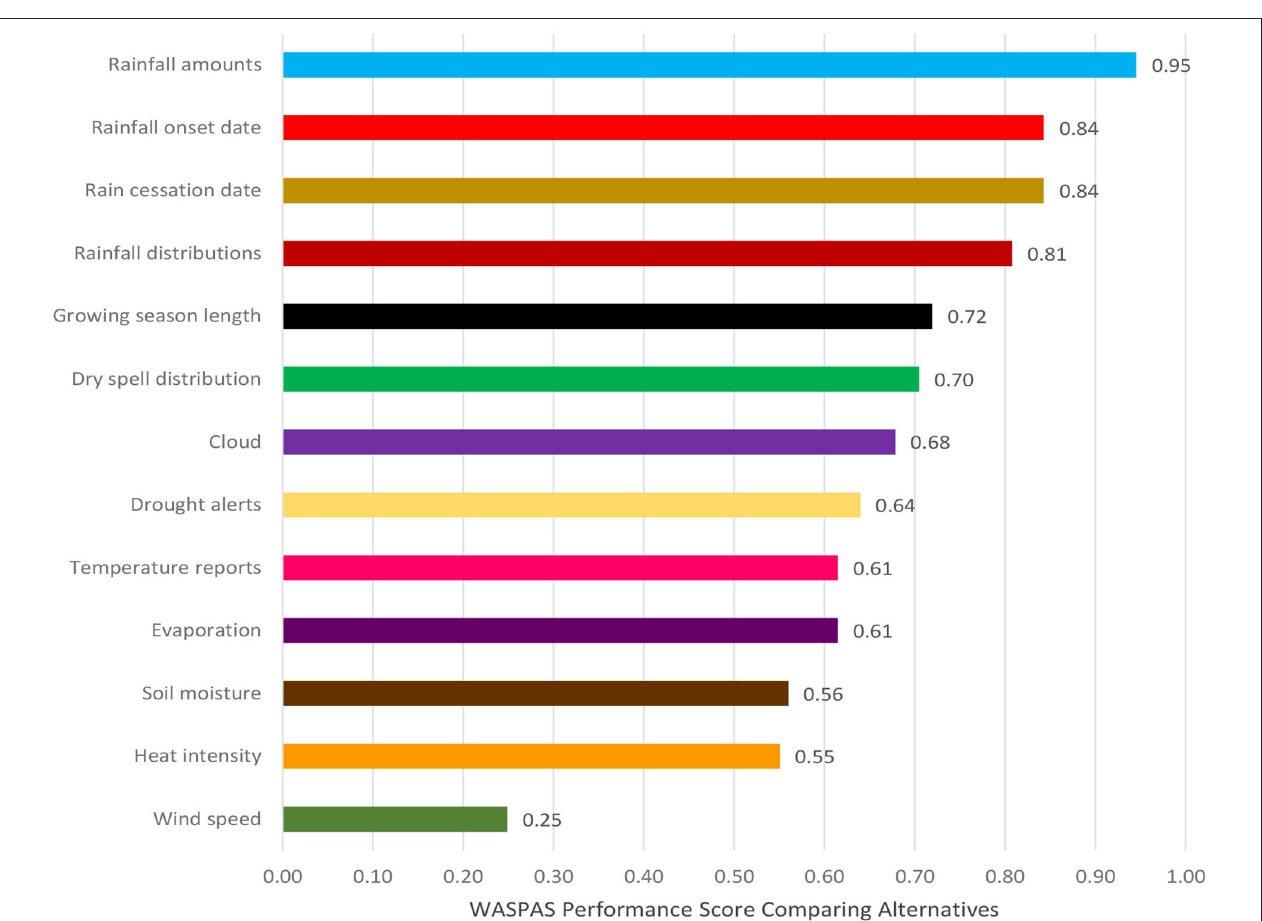
FIGURE 4 | Ranking relative importance of WCI alternatives in